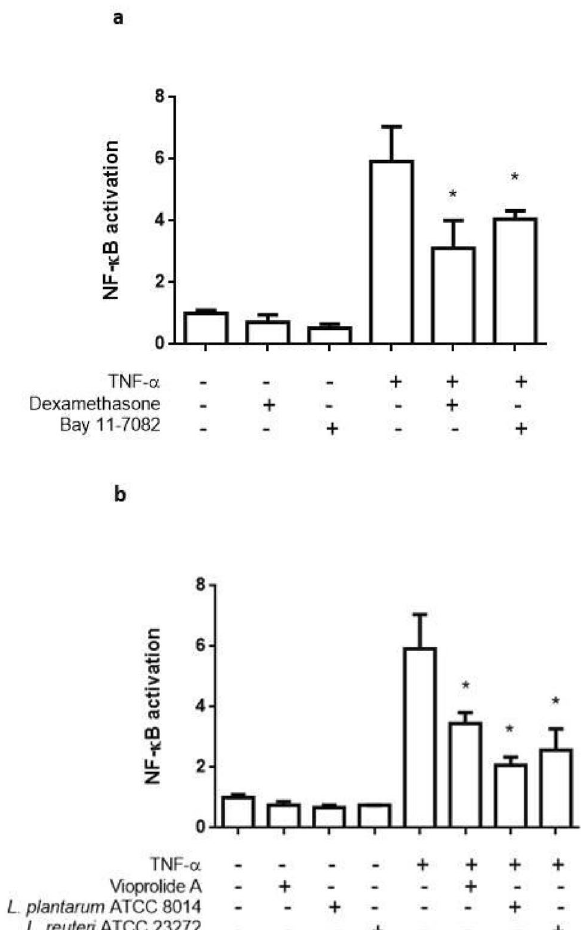
Figure 7. Validation of the NF-κB-RE-Luc organoids with anti-inflammatory compounds. NF-κB reporter organoids were stimulated with TNF-α 10 ng/mL and incubated with synthetic and natural antiinflammatory compounds for 24 h. NF-κB activation was determined as previously described. Cells without treatment and cells treated only with TNF-α or the different compounds were included as controls. ( a ) Known synthetic inhibitors of NF-κB pathway Dexamethasone and Bay 11-0782; ( b ) conditioned medium from probiotic L. plantarum and L. reuteri and the compound Vioprolide A were used as natural anti-inflammatory compounds. Data was expressed as mean ± SD of triplicates from one representative experiment * P < 0.05, significant differences with respect to unstimulatedorganoids for compounds alone, or to TNF-α 10 ng/mL for compounds co-incubated with proinflammatory